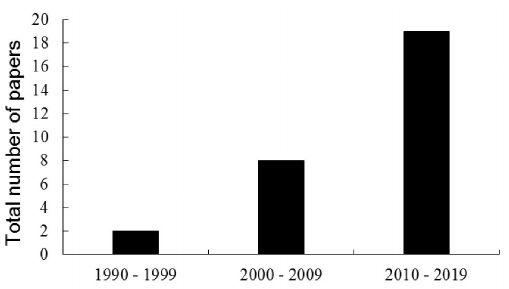
Figure 1. Total number of articles on abundance and space-temporal distribution of ichthyoplankton in the Brazilian Amazon basin, published in the last decades in national and international